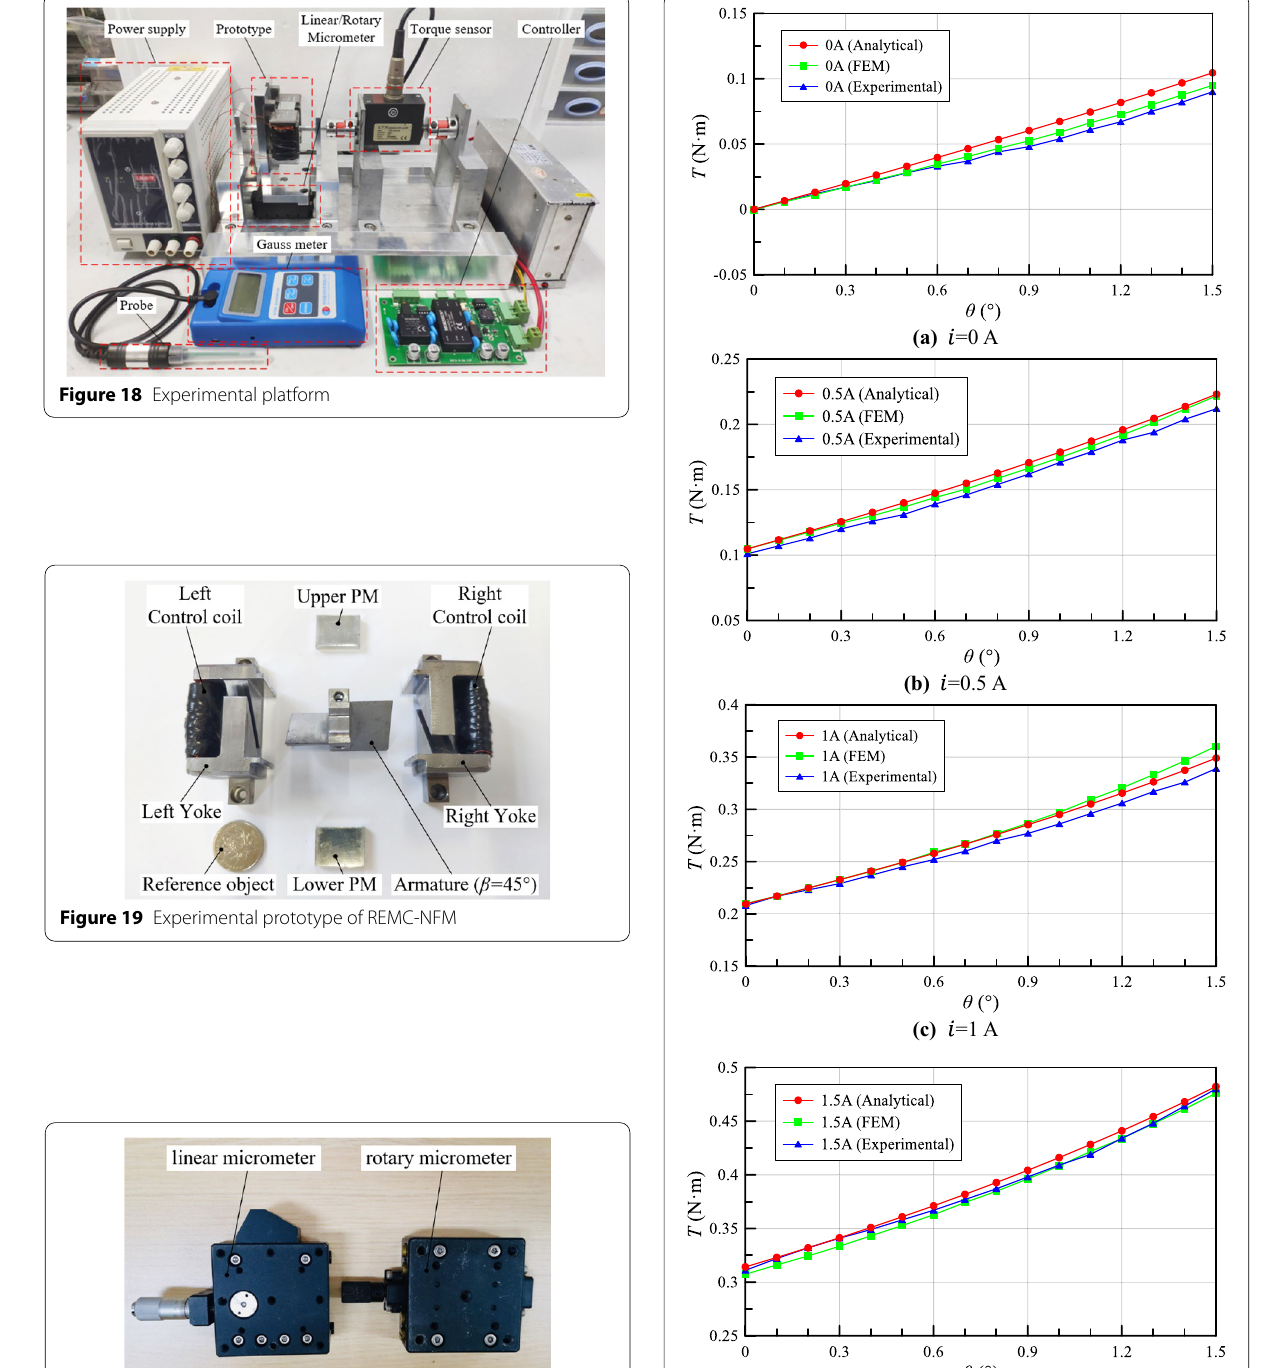
Figure 20 Linear micrometer and rotary micrometer